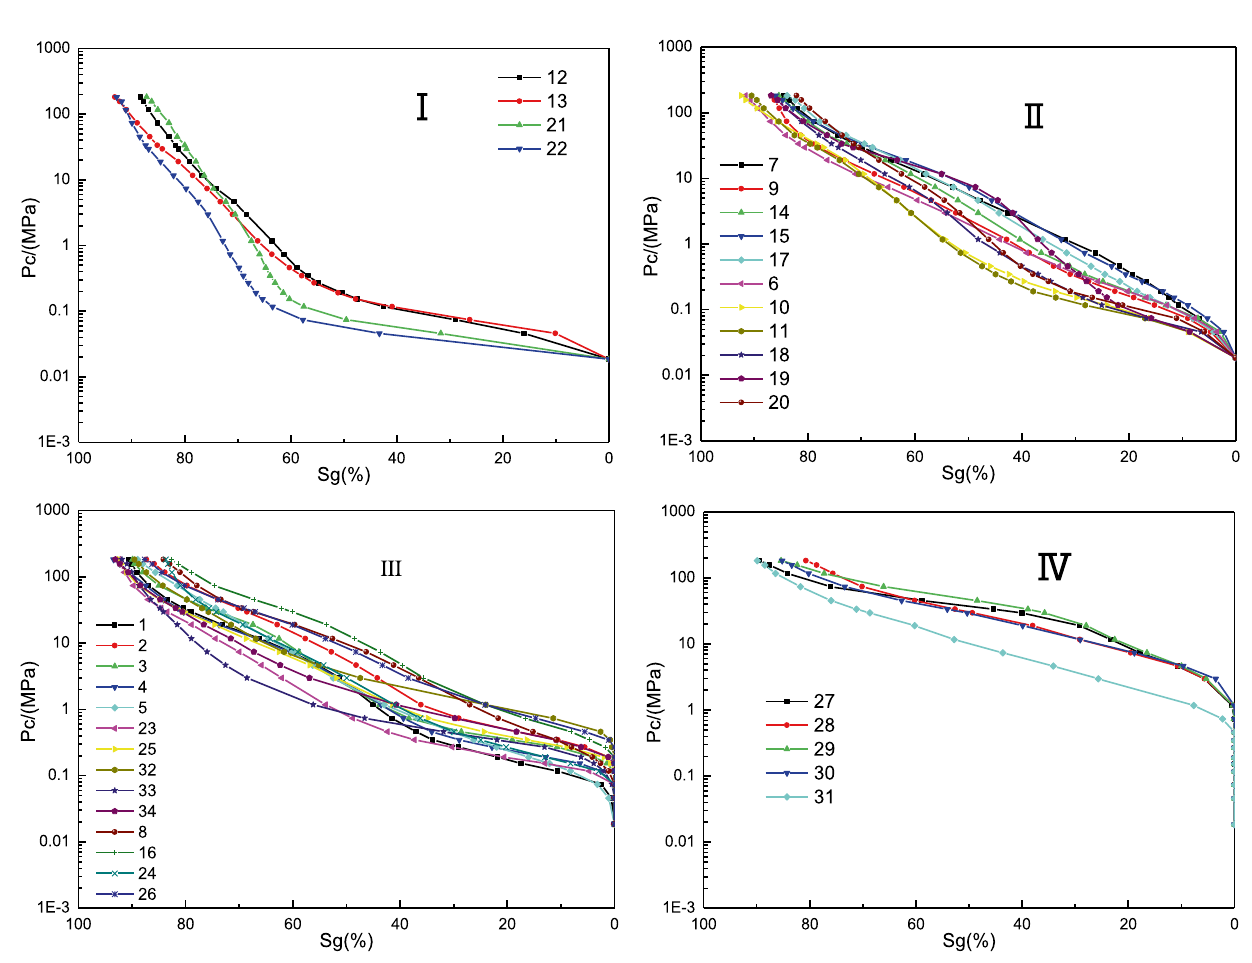
Fig. 1 Classification of pore structure based on mercury intrusion curve